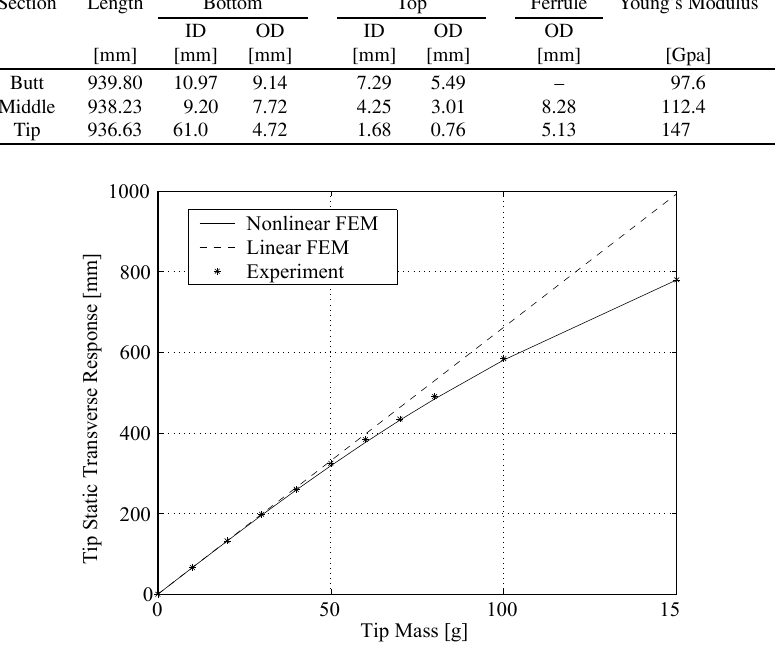
Fig. 7. Fly rod tip load and vertical de fl ection